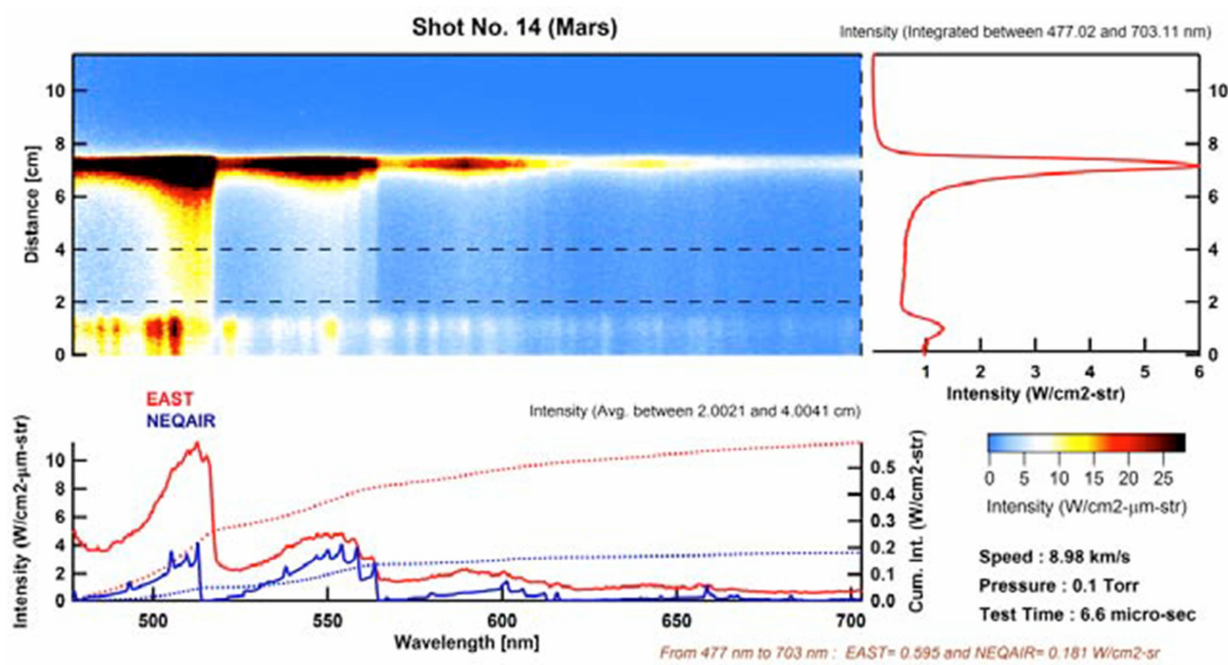
Figure 23. Comparison between NEQAIR calculations and EAST data in the VIS at 0.1 Torr and a shock velocity of 9 km/s. The dotted curves are the cumulated radiative intensity: measured in red and computed in blue (from